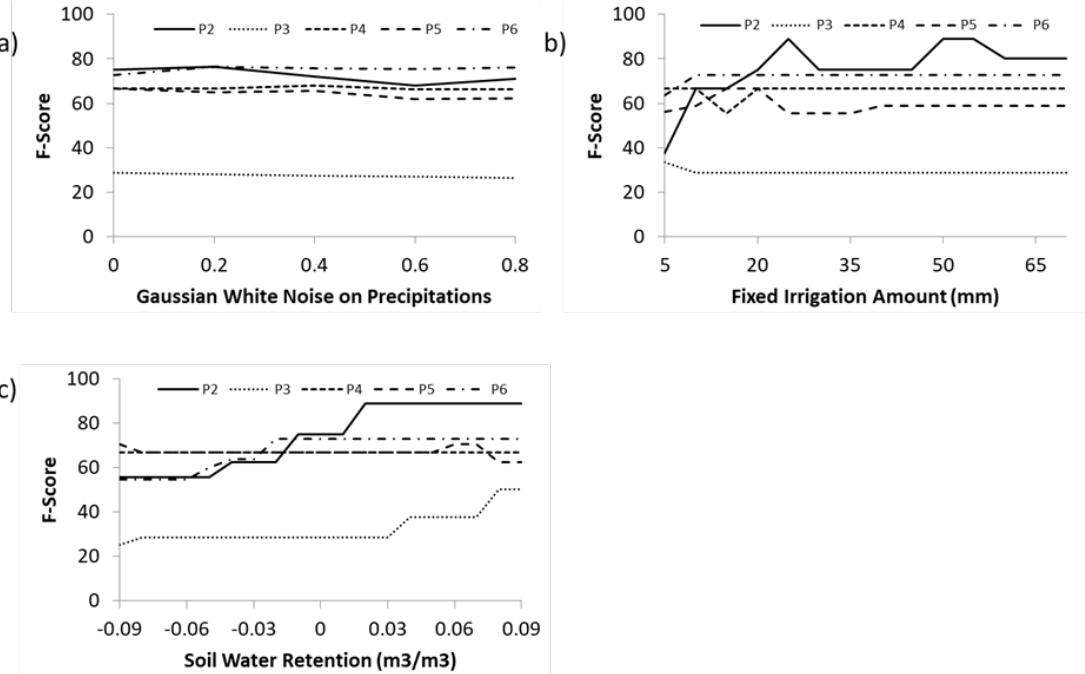
Figure 7. Sensitivity analysis on precipitation (a), irrigation amounts (b) and soil water retention (c).